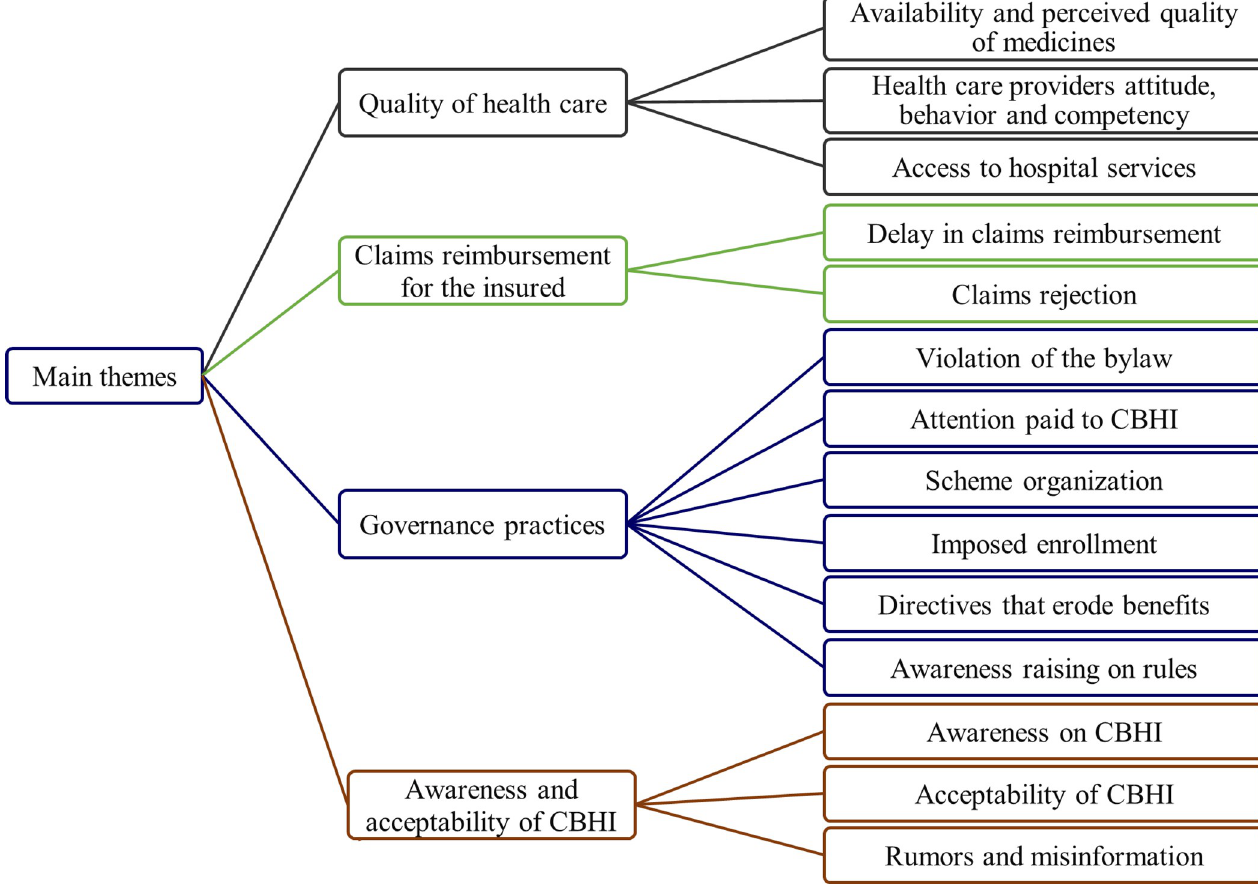
Fig 2. Main themes and sub-themes from interviews with CBHI members and key informants at two case study districts of northeast Ethiopia.